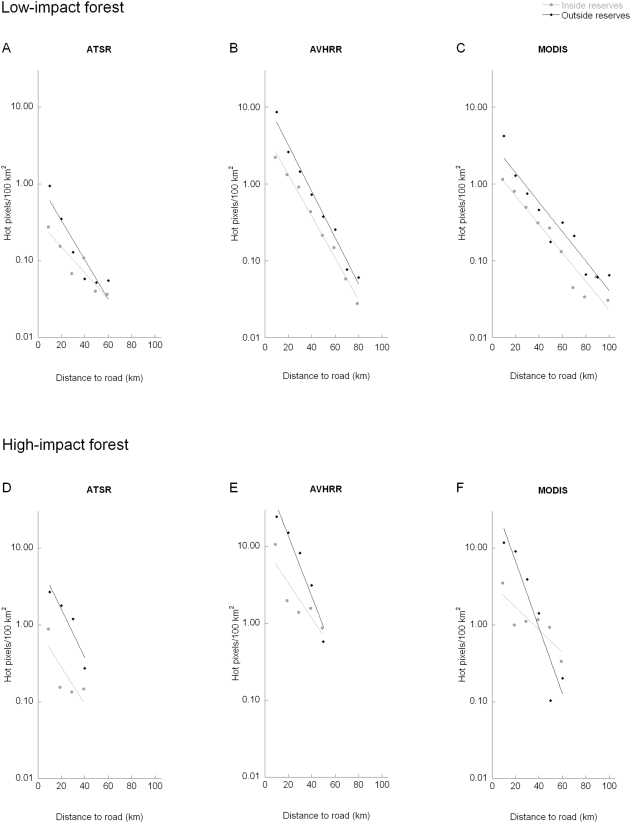
Relationship between 2001–2003 hot pixels/100 km2 and their distance to roads for 3 different sensors, ATSR/AATSR, AVHRR, and MODIS.A–C) low-impact and D–F) high-impact forests (low- and high- impact areas as shown in Fig. 1). Data are separated by whether fires are inside (grey) or outside (black) reserves. Fire rates were calculated on the basis of distance classes, but data points are offset from the class number for clarity (e.g., x values of 9 and 10 for class 10). All sensors detect at a 1-km2 resolution, but differ in detection algorithms and overpass times.